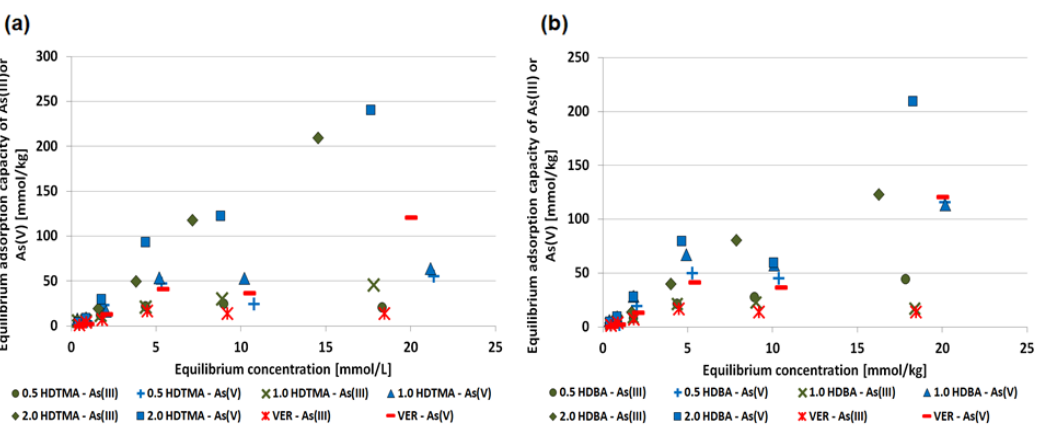
Figure 9. Sorption of As(III) or As(V) ions as a function of equilibrium concentration for ( a ) VER, 0.5 HDTMA, 1.0 HDTMA, and 2.0 HDTMA, and ( b ) VER, 0.5 HDBA, 1.0 HDBA, and 2.0 HDBA.